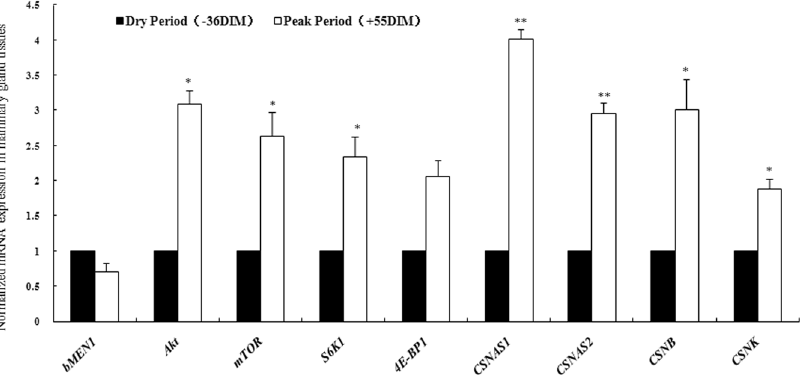
Figure 4. The effect of MEN1/ Menin expression on the process of protein synthesis was confirmed at different lactation periods in mammary gland tissue. Bovine mammary gland tissues at two different lactation periods, peak milk period ( + 55DIM, days in milking) and dry period before parturition (-36DIM), were collected and used to detect the expression levels of MEN1 , genes involved in the PI3K/Akt/mTOR pathway and the milk protein transcripts CSNAS1 ( α s1-casein), CSNAS2 ( α s2-casein), CSNB ( β -casein), CSNK ( κ -casein), LGB ( β -lactoglobulin) and LALBA (alpha-lactalbumin). The expression of MEN1 in the peak milk period ( + 55DIM) was lower ( P = 0.06) than its expression in the dry period (-36DIM). The expression levels of Akt , mTOR , S6K1 and 4E-BP1 , along with the 6 milk protein components, were increased in the peak milk period compared to those in the dry period. The results in mammary gland tissues were consistent with the observations from experiments conducted in the mammary epithelial cells.